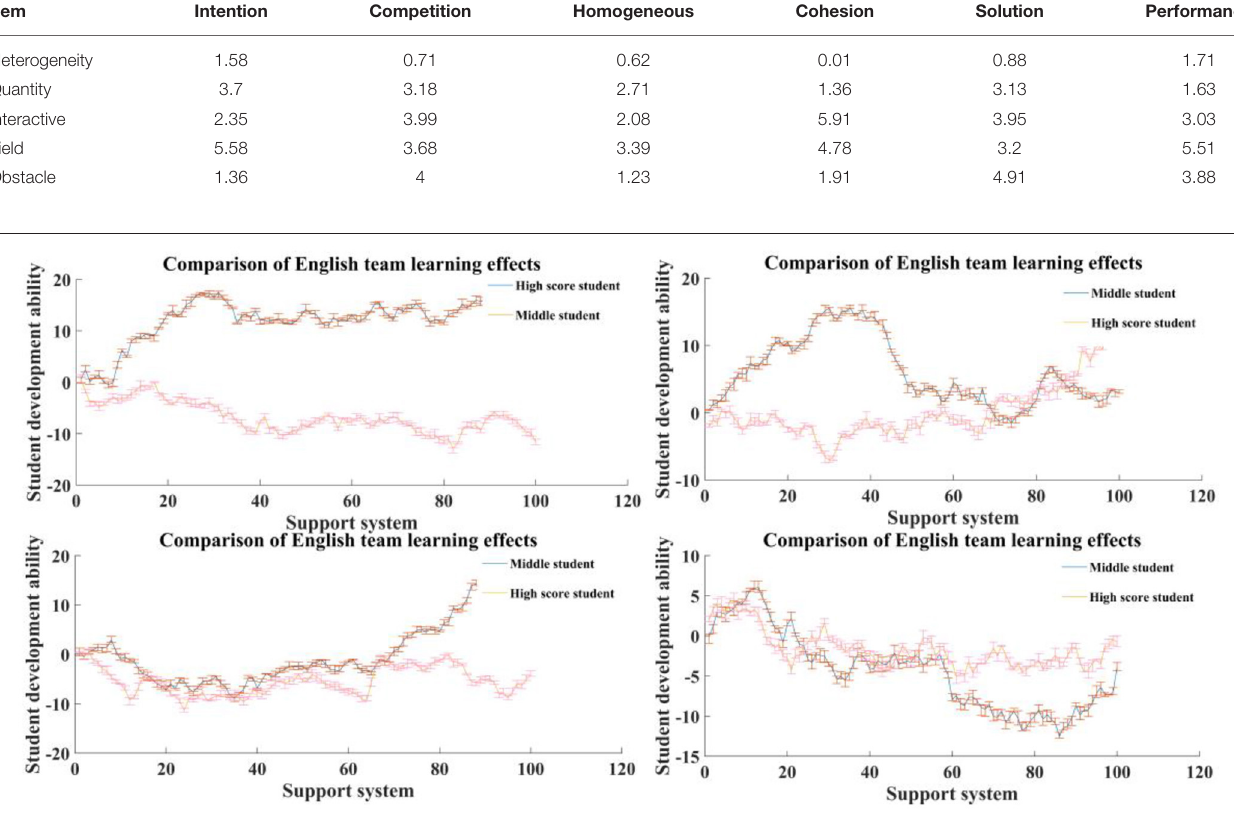
FIGURE 8 | Comparison of English team learning